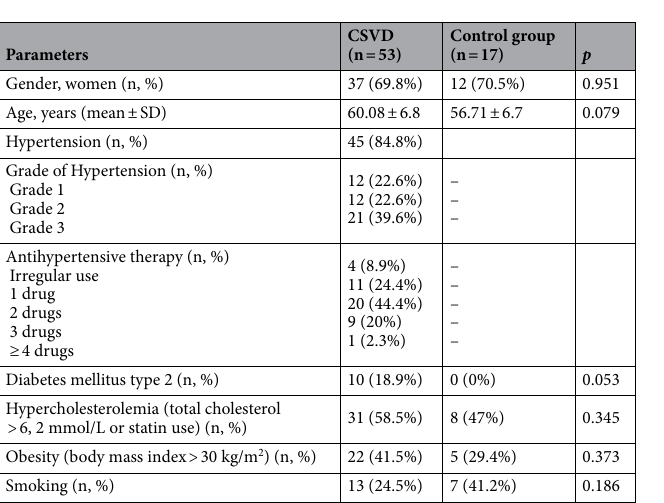
Figure 1. Example of MRI data of CSVD patient. Ktrans, AUC and Vp maps ( A ). T2 - Flair image and superimposion of GM, NAWM and WMH masks over the individual ktrans permeability map ( B ).